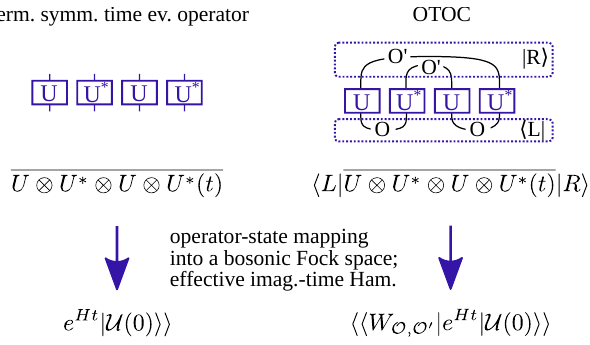
Figure 4 . Schematic diagram summarizing our method. The dynamical information about the OTOC is uniquely encoded in the operator de(cid:12)ne the \right" and \left" states symmetry, we can map U